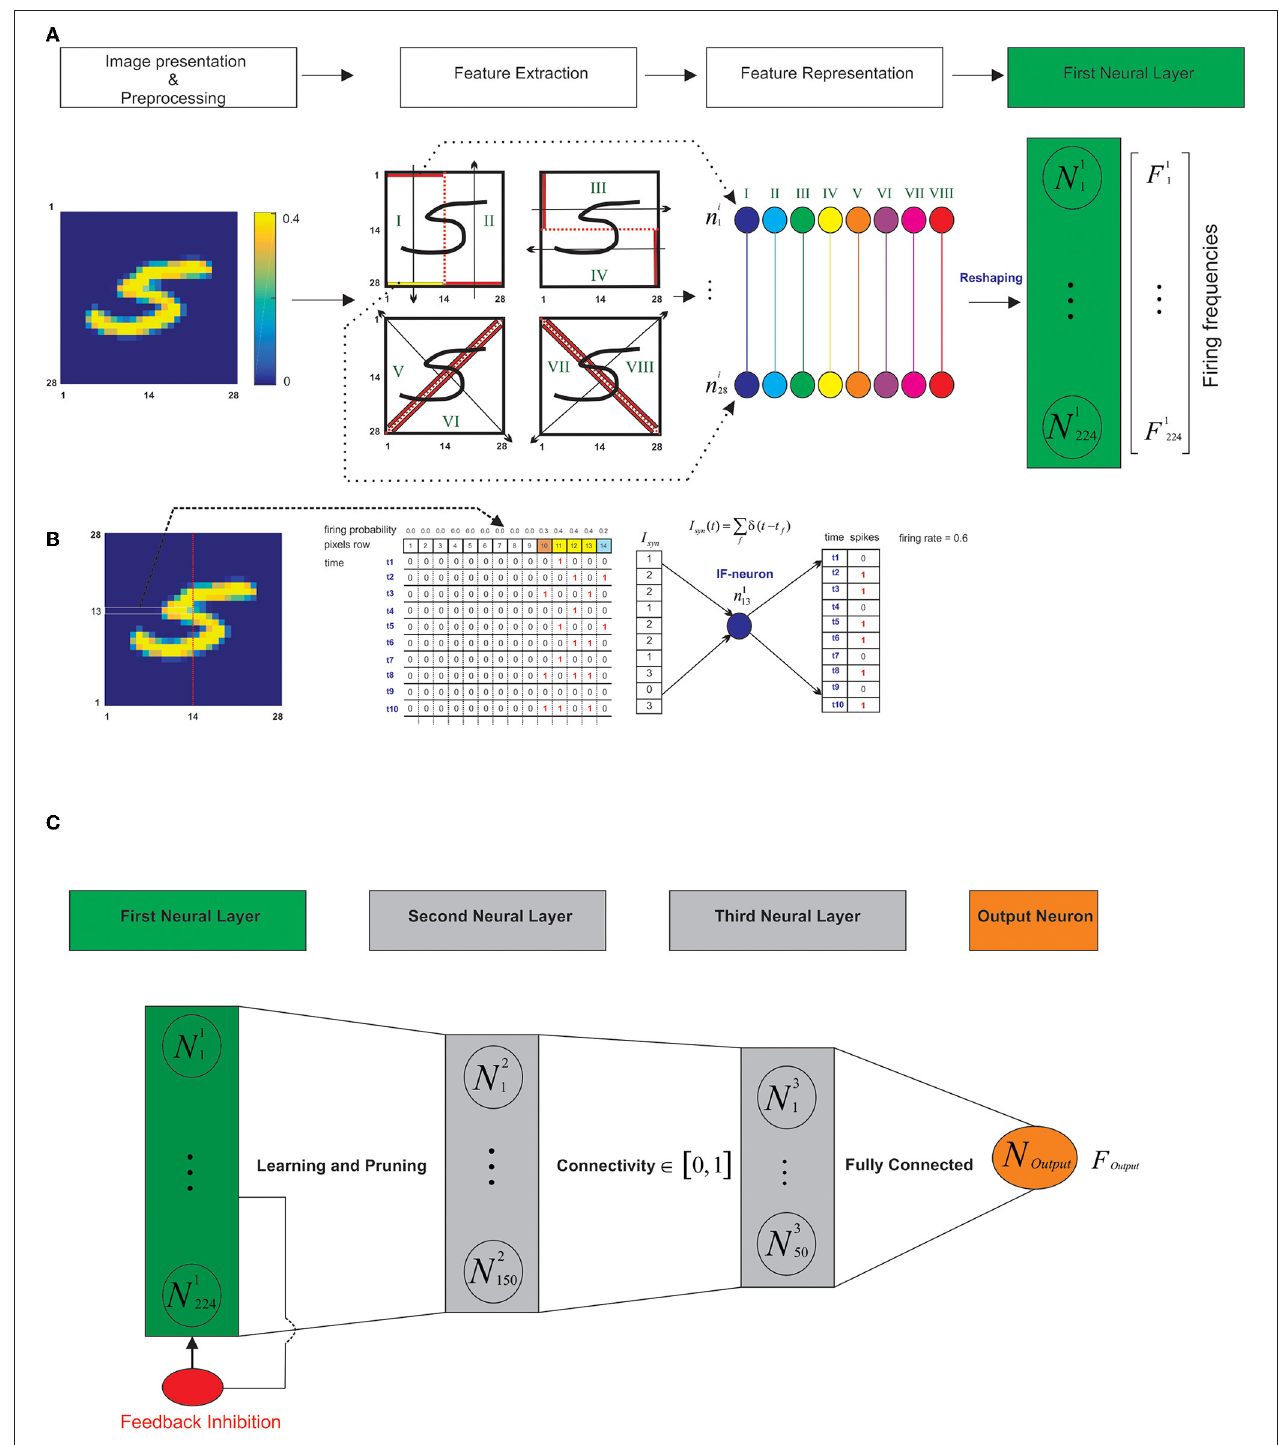
FIGURE 2 | Schematic representation of the architecture of the model. (A) The feature representation of the image as spiking neurons in the first layer. After data preprocessing, the image is presented as a matrix of pixels with values between 0 and 0.4. The matrix is divided into eight regions. The information of each region (shown from I to VIII) is represented as 28 spiking neurons. The first spiking neural layer as a feature representation is constructed by concatenation of spiking neurons of the regions as a neural layer with 224 spiking neurons. (B) Each pixel of the selected-set of pixels as horizontal, vertical, or diagonal segments are considered as “spike train generators” with mean firing frequency proportional to the intensity of the pixels (here horizontal set of pixels as the 13th row). To represent the information of the pixel as a spiking activity of a probabilistic neuron, a uniform distribution is used to generate vectors composed of sequential 1s and 0s (10 time bins